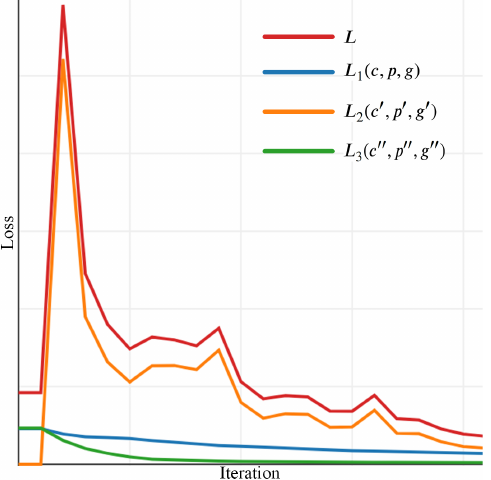
Figure 4. Training loss. L 1 ( c , p , g ) is the loss of the ALPD module in the indirect detection branch. L 2 ( c (cid:48) , p (cid:48) , g (cid:48) ) is the loss of the MLPR module in the indirect detection branch. L 3 ( c (cid:48)(cid:48) , p (cid:48)(cid:48) , g (cid:48)(cid:48) ) is the loss of the DLPD module in the direct detection branch. L is the total loss of the end-to-end